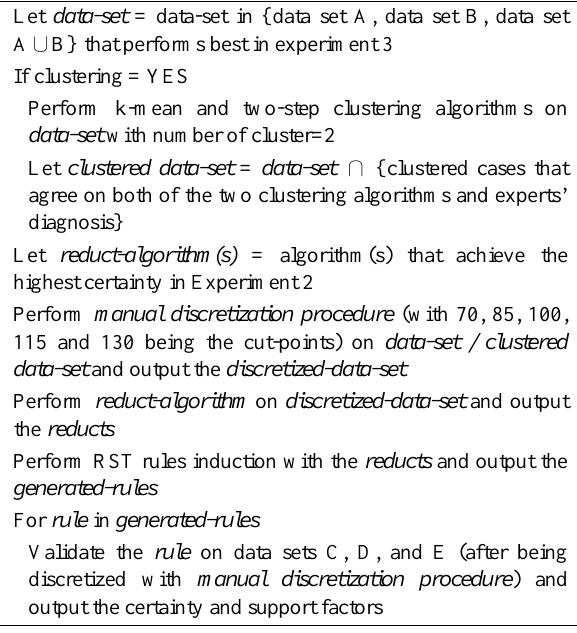
Table 5. Procedure of Experiment